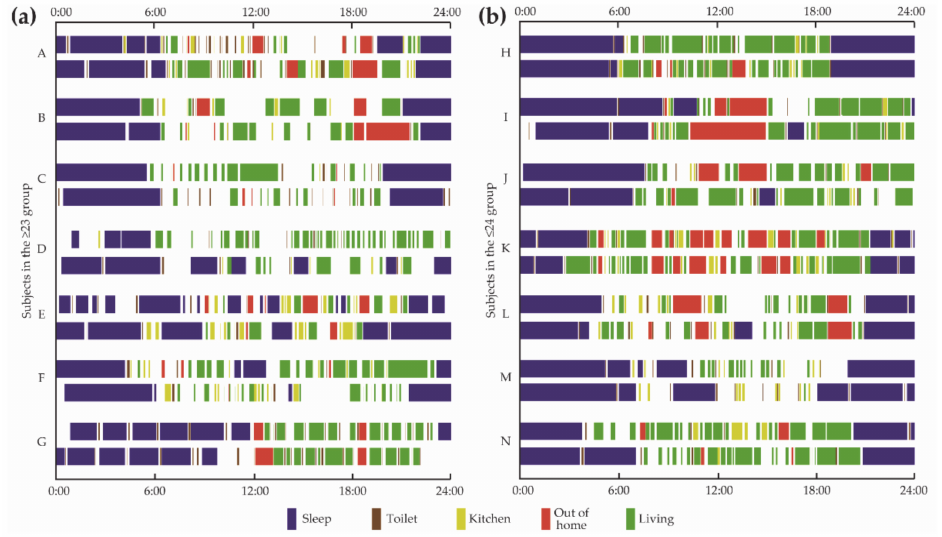
Figure 6. Daily activity maps of all the subjects (a) in the ≤ 23 groups and (b) in the ≥ 24 groups, visualized from sensor data. The upper bar of each subject is a typical activity map at the BLp. The bottom bar of each subject is a typical activity map at the